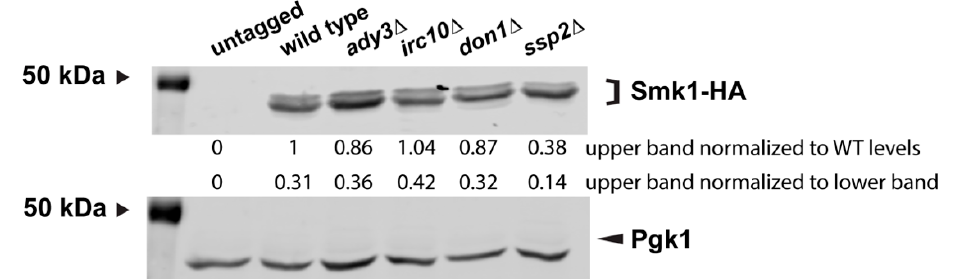
Figure 5. Smk1 post-translational modification does not require the leading edge protein complex members ADY3 , IRC10 , and DON1 . Immunoblot of protein extracts examining Smk1-HA in an untagged strain lacking Smk1-HA (LH177), Smk1-HA (LH178), ady3 ∆ (LH1126), irc10 ∆ (LH1127), don1 ∆ (LH1128), and ssp2 ∆ (LH1129). Pgk1 is used as a loading control. The 50 kDa band from the Precision Plus Protein Markers (BioRad) is indicated on the left of each blot. The upper quantification corresponds to densitometry, in which the slower migrating (upper) Smk1-HA band was first normalized to Pgk1 levels, followed by the normalization of the slower migrating Smk1-HA band in each mutant to wild-type levels of expression. The lower quantification corresponds to densitometry, in which the slower migrating Smk1-HA band was normalized to the faster migrating Smk1-HA band for each genotype.